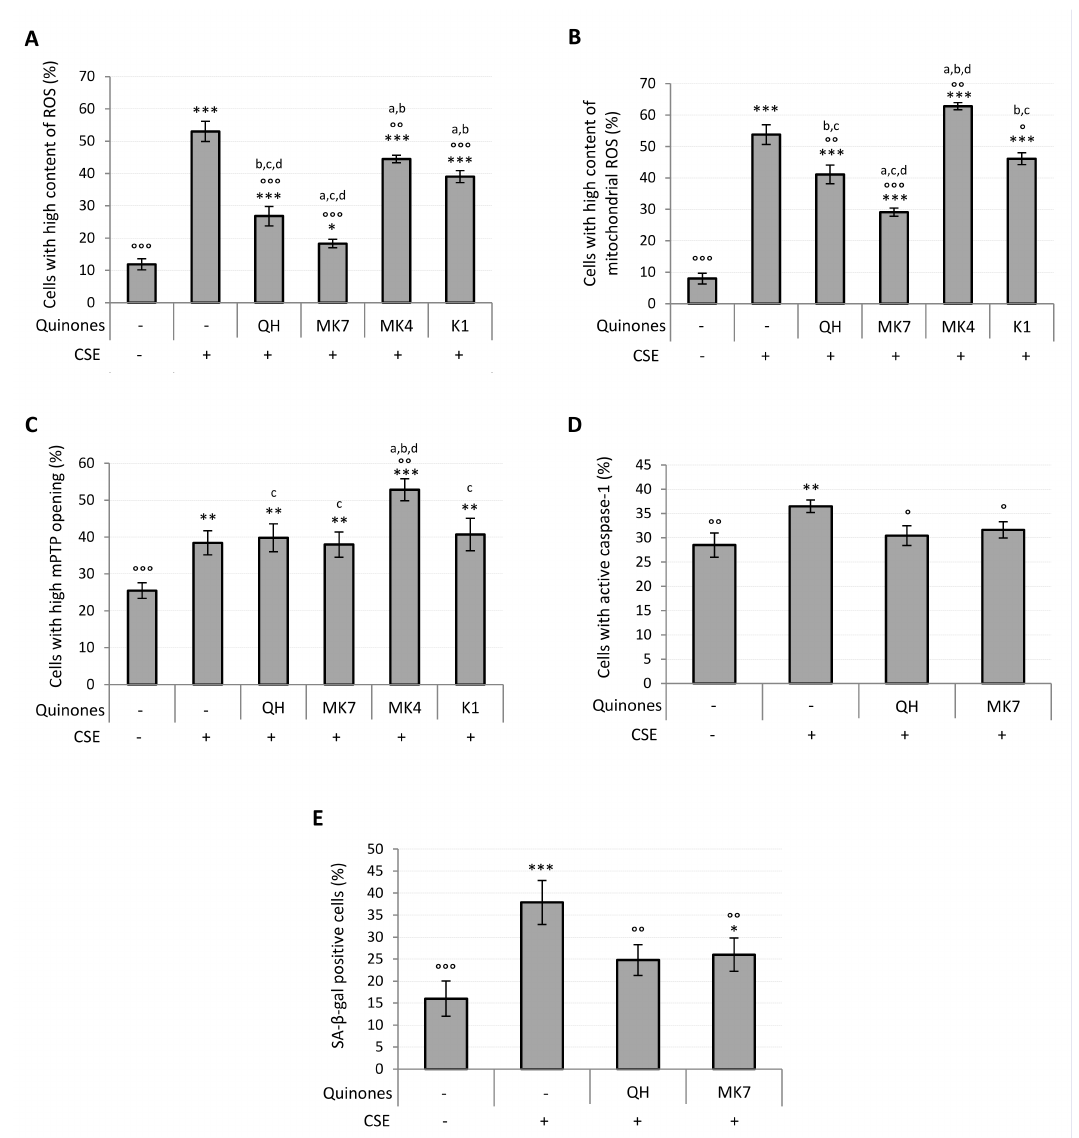
Figure 6. E ff ect of quinones supplementation on oxidative stress, mitochondrial functionality, caspase-1 activation and senescence in young HUVECs exposed to CSE (0.425 pu ff s / mL for 24 h). Cells were supplemented with 10 µ M quinones followed by replacement with CSE medium containing the same quinones and incubated for a further 24 h (except in the case of SA- β -galactosidase activity where cells were incubated for 48 h). Percentage of cells with: ( A ) high ROS content, ( B ) high mitochondrial ROS content, ( C ) high mPTP opening, ( D ) active caspase-1, ( E ) SA- β -galactosidase positive cells. + and – represent exposure or not exposure, respectively, to the indicated substances. ◦ p ≤ 0.05, ◦◦ p ≤ 0.01, ◦◦◦ p ≤ 0.001 vs. CSE-treated cells; * p ≤ 0.05, ** p ≤ 0.01, *** p ≤ 0.001 vs. untreated HUVECs; a vs QH; b vs MK7; c vs MK4; d vs